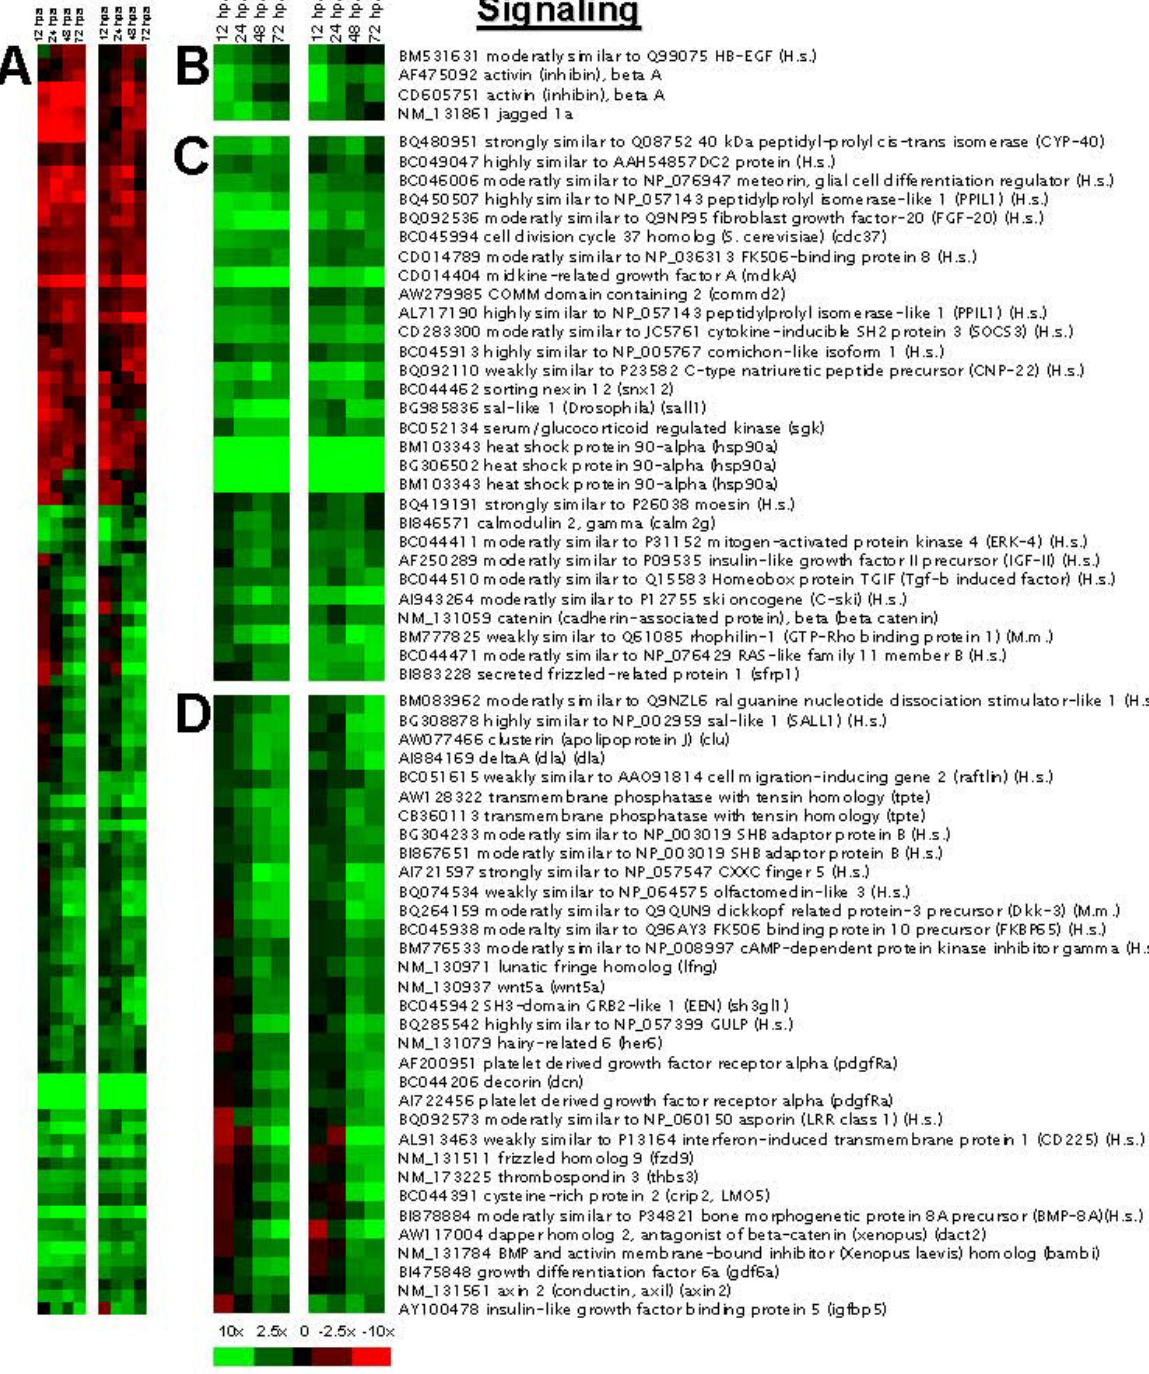
FIGURE 4. Expression patterns of genes involved in signaling. (A) Hierarchical clustering of all signaling genes. (B–D) Expression patterns, GenBank accession numbers, and names of signaling genes, which showed increased expression early (12 and 24 hpa, B), later (48 and 72 hpa, D), or throughout regeneration (C). H.s., Homo sapiens; M.m., Mus